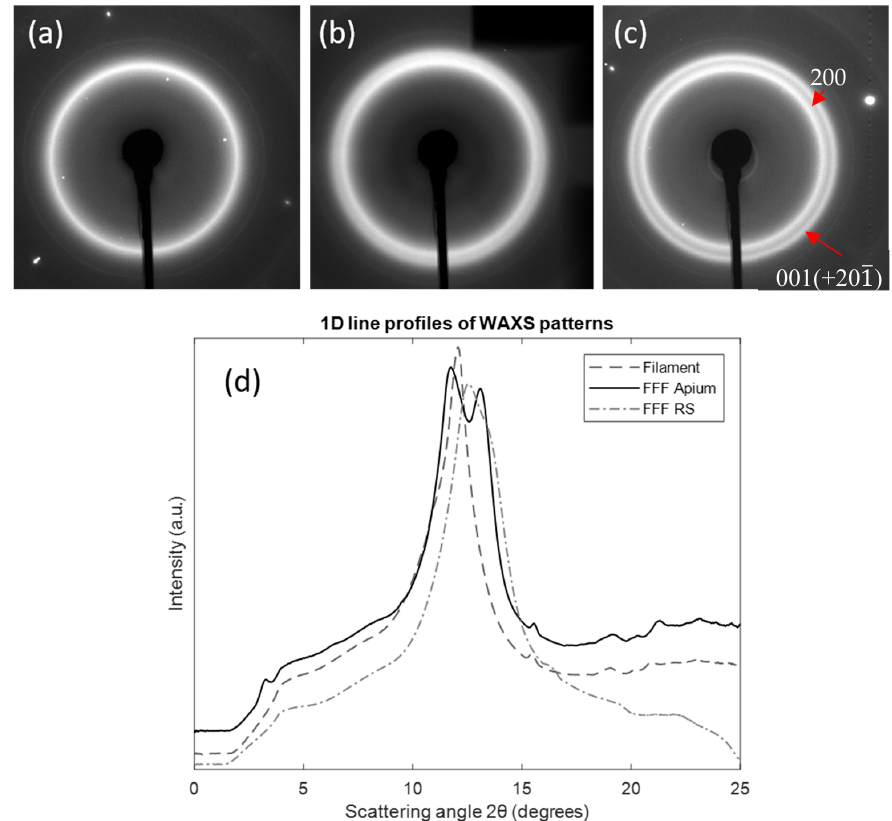
Figure 7. One-dimensional WAXS patterns (shifted vertically for clarity) for the four samples as a function of temperature during cooling. The small peak at 2 θ = 12.5 °C is due to background diffraction.